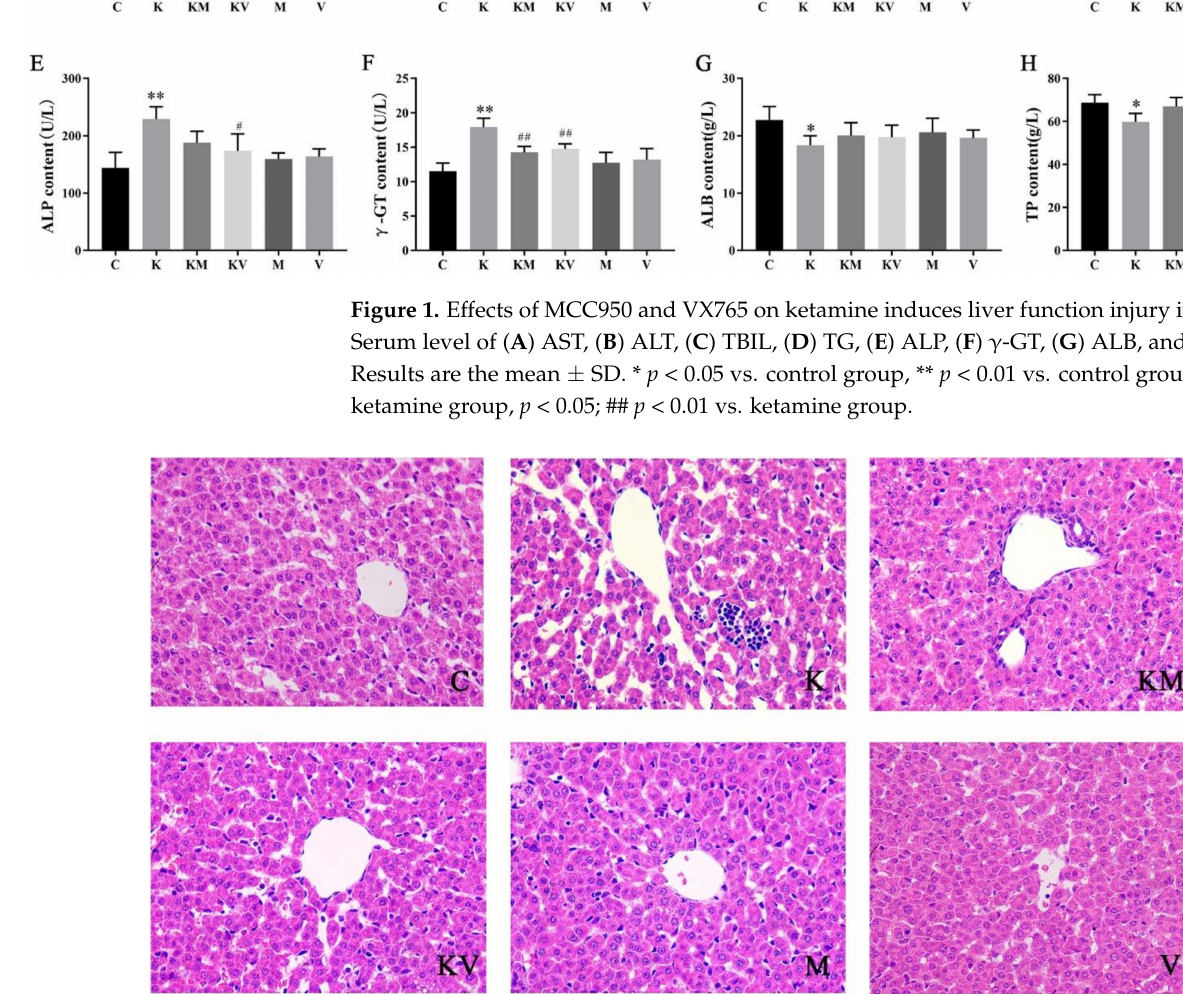
Figure 2. Liver sections for histological examination by hematoxylin and eosin staining (H&E) at × 400 ( n =